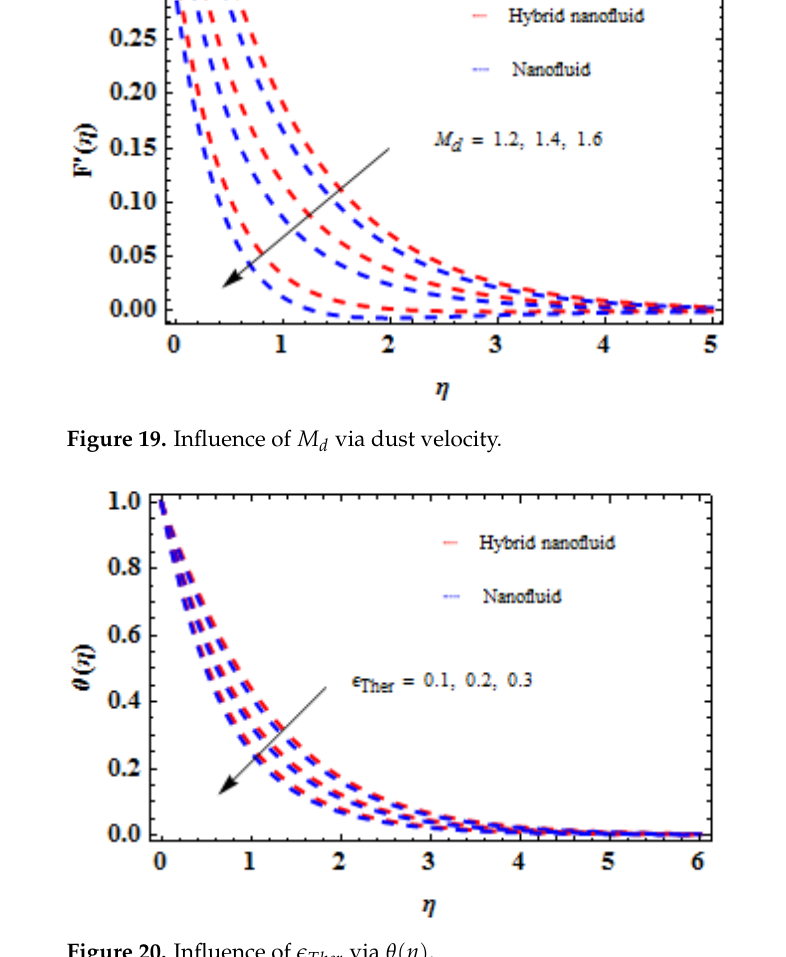
Figure 20. Influence of 𝜖 𝑇ℎ𝑒𝑟 via 𝜃(𝜂).